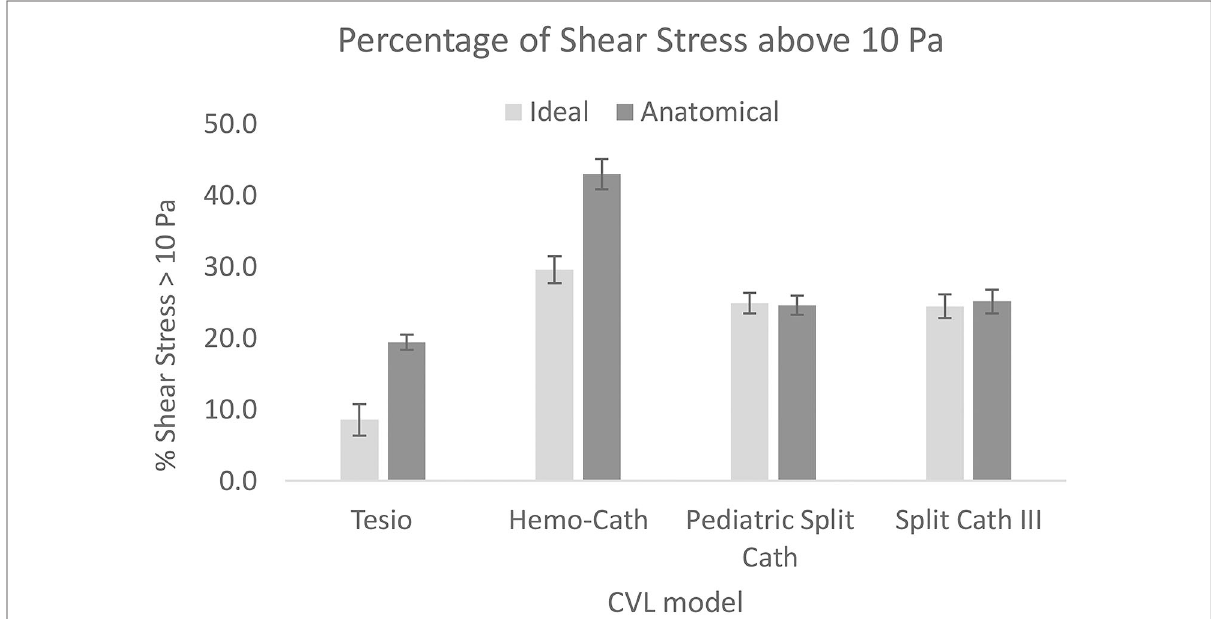
FIGURE 7 Comparison of the shear stress levels between the ideal and the anatomical model. For each CVL model, the average of the three fl ow rates is reported. CVL=Central venous